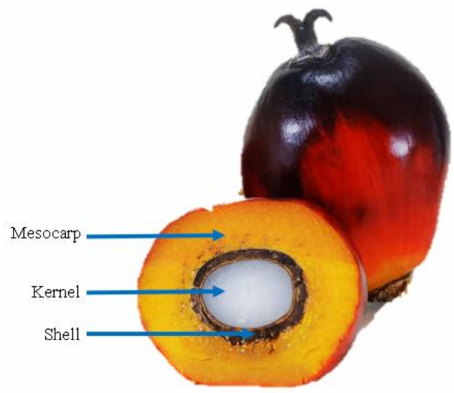
Figure 5. Cross-section of a